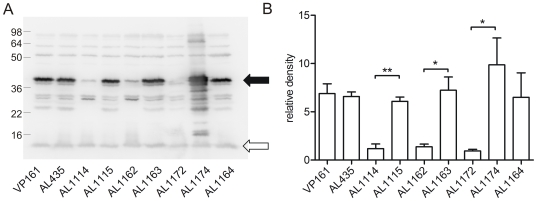
Western immunoblot and densitometry analysis of P. multocida PlpE expression in acapsular, capsulated and control strains.Western immunoblot using chicken antiserum against recombinant PlpE (A) and the corresponding quantitive densitometry analysis (B). The levels of PlpE expression were measured in the capsulated parent strains (VP161, AL435), the acapsular fis mutants (AL1114, AL1162) and paired capsulated strains (AL1115, AL1163), a single-crossover plpE mutant (AL1172; Hatfaludi, Al-Hasani and Adler, unpublished data), complemented plpE mutant (AL1174) and the acapsular phyB mutant strain that produces no HA (AL1164). The filled arrow head represents the position of PlpE, whilst the unfilled arrowhead represents the background band used as a loading control for densitometry normalization. Each bar represents the average normalized densitometry readings from triplicate biological replicates ±1 SEM. ** p<0.01, * p<0.05.